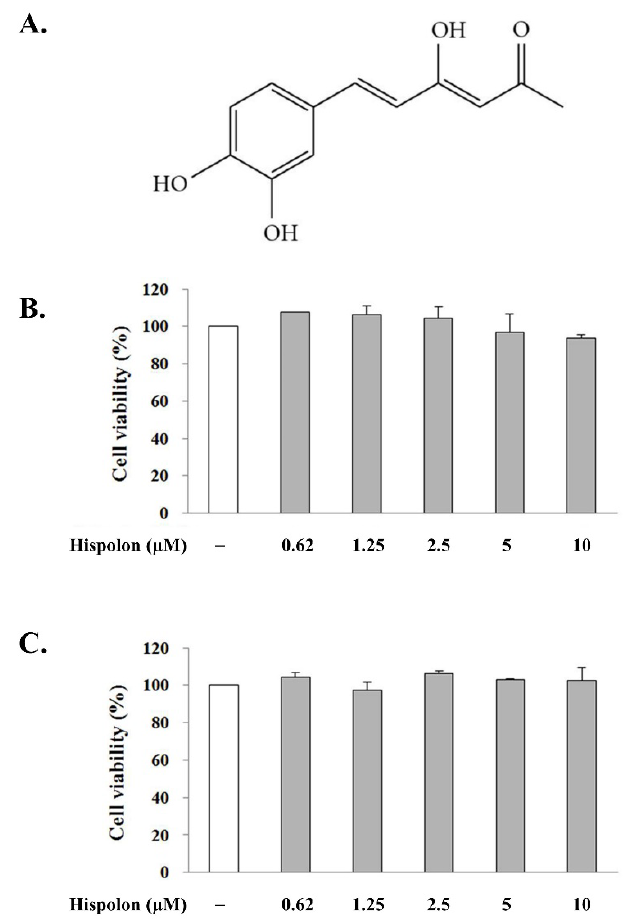
Figure 1. Effect of hispolon on the viability of RAW264.7 cells. Cell viability was measured using the CCK-8 reagent, as described in the Materials and Methods section. ( A ) The chemical structure of hispolon. The cells were incubated with hispolon ( B ) 6 h or ( C ) 24 h. The data are presented as the means ± SD of three separate experiments performed in triplicate ( n = 3). Significance was analyzed using one-way ANOVA.